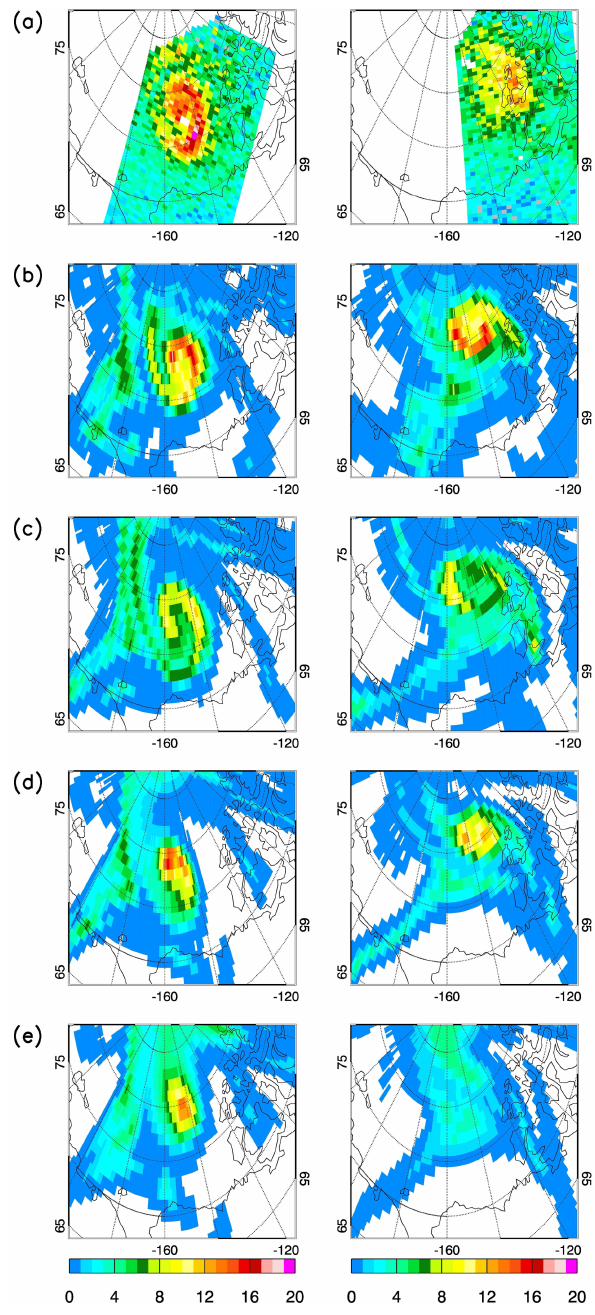
Figure 8. FLEXPART FS1 simulations of BrO tropospheric VCD [10 13 moleccm − 2 ] for (left) 1 April 2011 at 21:30UTC (mature stage of the BCTE) and (right) 2 April 2011 at 19:30UTC (dis- solving stage of the BCTE) assuming that the plume was located between (b) 0–1km, (c) 3–5km, (d) 7–9km and (e) 9–11km alti- tude at time of initialisation. The corresponding GOME-2 retrievals of BrO tropospheric VCD [10 13 moleccm − 2 ] are shown by panels in (a) for comparison. See Sect. 3.2 for details on the model